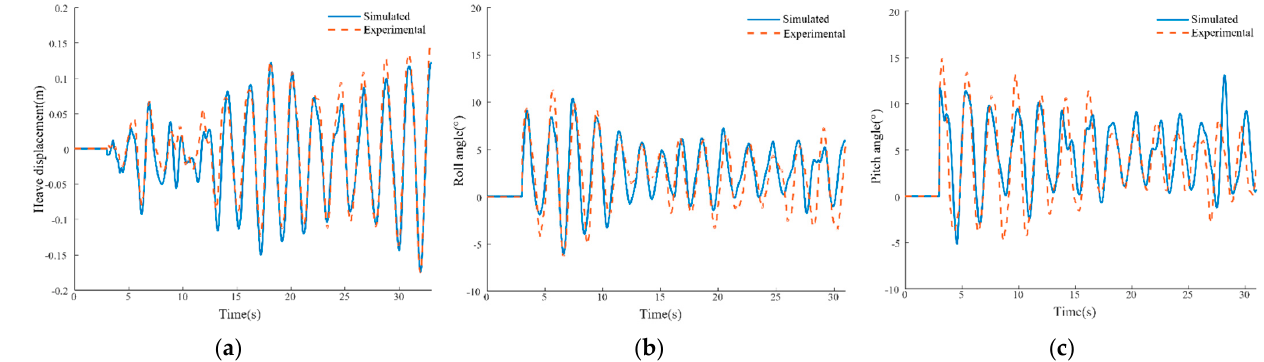
Figure 10. Comparison of simulated and experimental data. ( a ) Heave displacement; ( b ) Roll angle; ( c ) Pitch angle.